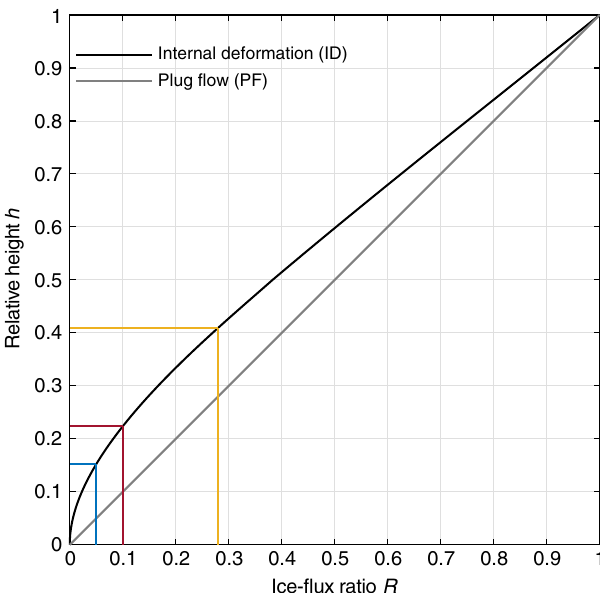
Fig. 6 Relationship of relative plume height h to the ice- fl ux ratio R of basally derived ice fl ux to the total ice fl ux. Vertical fl ux shape function for internal deformation (solid line) and plug fl ow (grey line) obtained from R as a function of h . h for 5, 10 and 28% (blue, red and yellow lines) of total ice fl ux Q are highlighted. A R of 1 is equivalent to the total ice fl ux